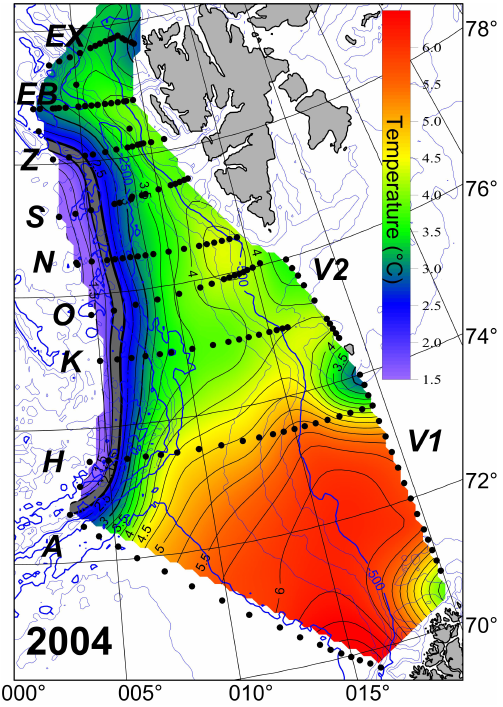
Fig. 3. Temperature at the 200m level. Positions of the CTD profiles and section names are marked. The Arctic Front position is marked by the grey